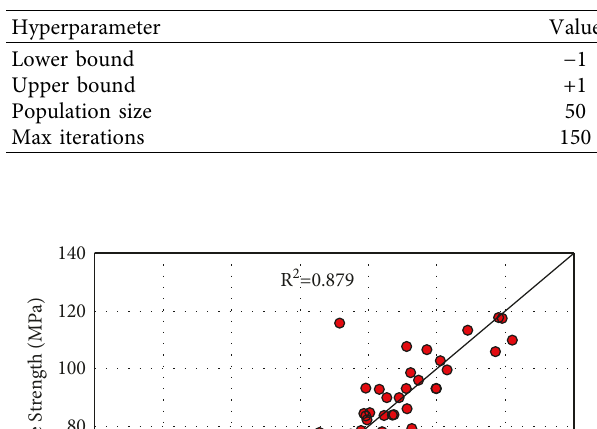
Table 7: Teaching-learning-based-optimization hyperparameters.